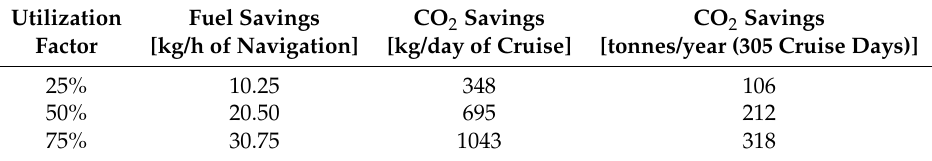
Table 4. Savings achievable operating the proposed plant when beyond 12 miles from the coast.